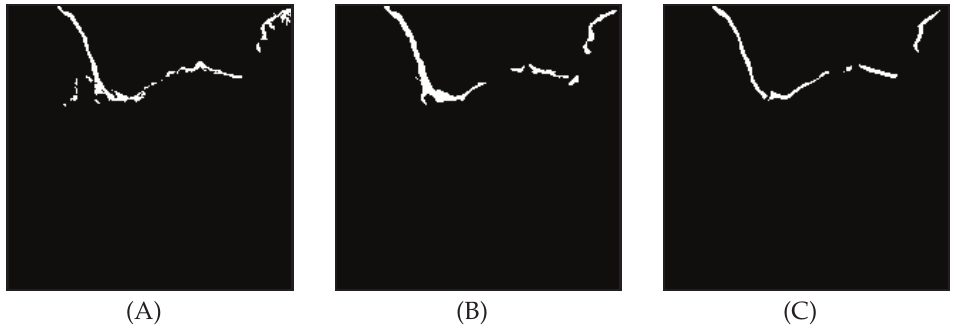
Figure 16: Pixels retrieved for beach concept (in white) by reasoning (A) and by experts analysis (B and